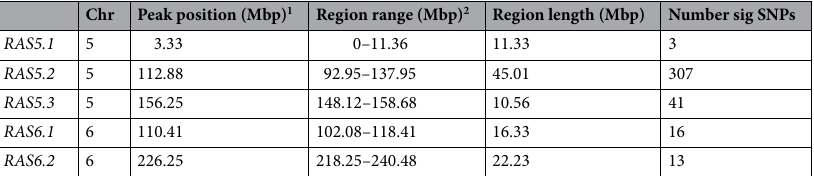
Table 2. Significant genomic regions identified by Bulk Segregant Analysis (BSA) for root-adhering soil aggregation (i.e. RAS/RT) at the 95% confidence interval. 1 Position of the most significant SNP in the region range. 2 Limits of the significant region considering the overlapping confidence interval of significant markers in the region.